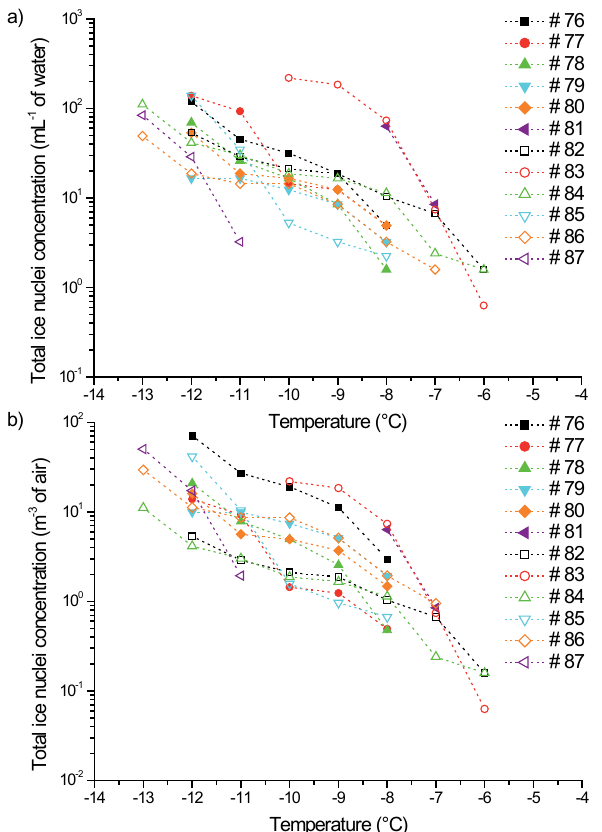
Figure 3. Cumulative concentration of total IN in the cloud sam- ples. (a) per volume of water sample (mL − 1 ) and (b) per corre- sponding volume of cloud air (m − 3